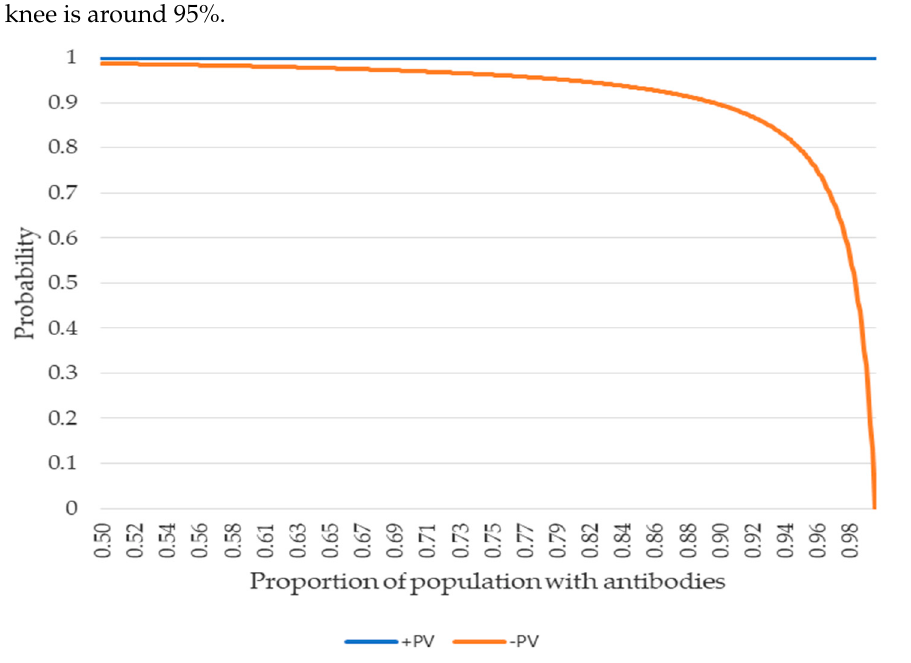
6 of 11 SD: Standard Deviation, 95% CI: 95% confidence interval, Sig.: Statistical significance t ‐ test. U ‐ Sig.: Statistical significance U Mann–Whitney test. NS: No statistically significant. Table 3 lists the results of the verification of the new rapid test based on the results of the sVNT ‐ ELISA test and its verification characteristics. No false ‐ positive results were recorded, and the LFIC test registered a sensitivity of 98.7% and a specificity of 100%. This table depicts the diagnostic accuracy of the assay, including specificity of 100%